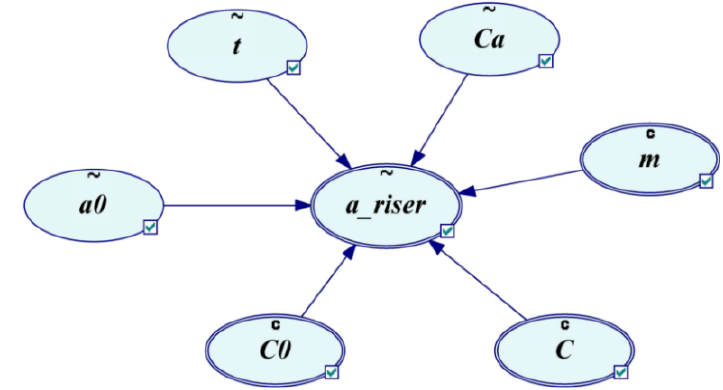
Figure 13. The BN model.